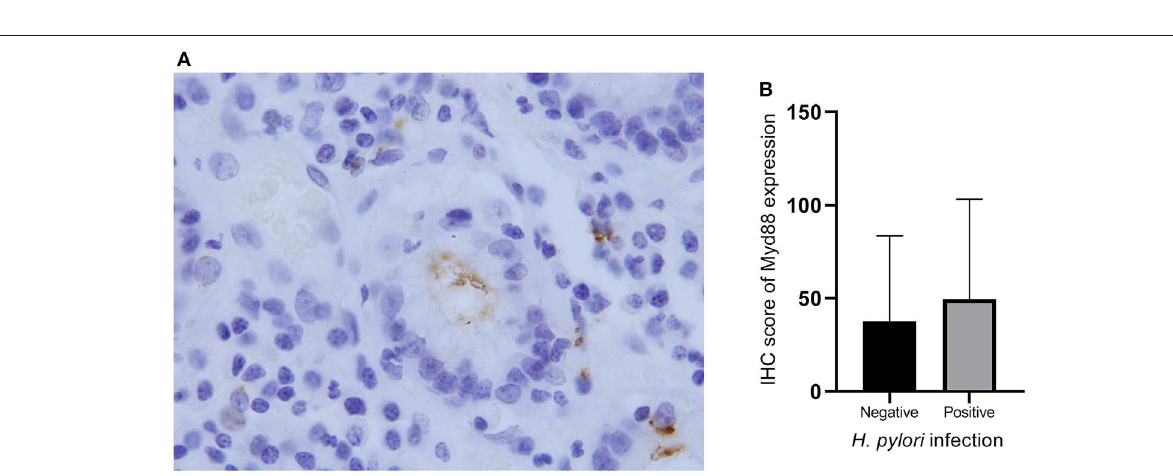
FIGURE 3 | Helicobacter pylori infection and MyD88 expression. (A) Helicobacter pylori infection was identified by IHC in gastric cardia glands. (B) Boxplot shows that MyD88 expression was higher in the severe H. pylori infection cases than the cases without H. pylori infection but not significantly.